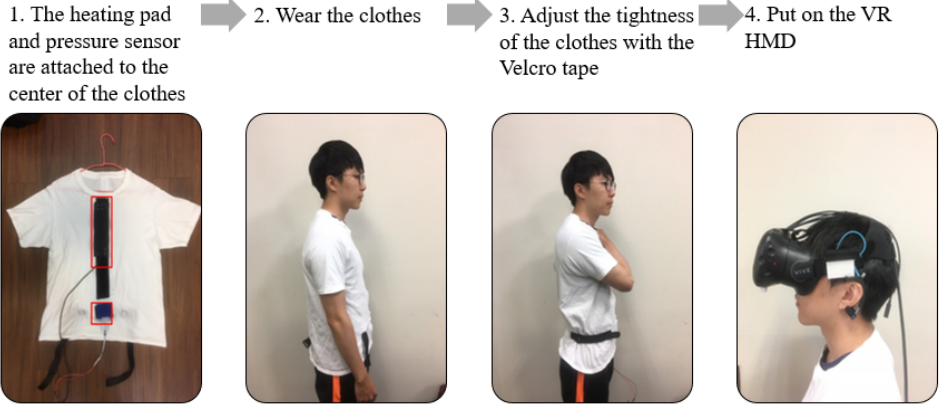
Figure 8. The user procedure of our study.